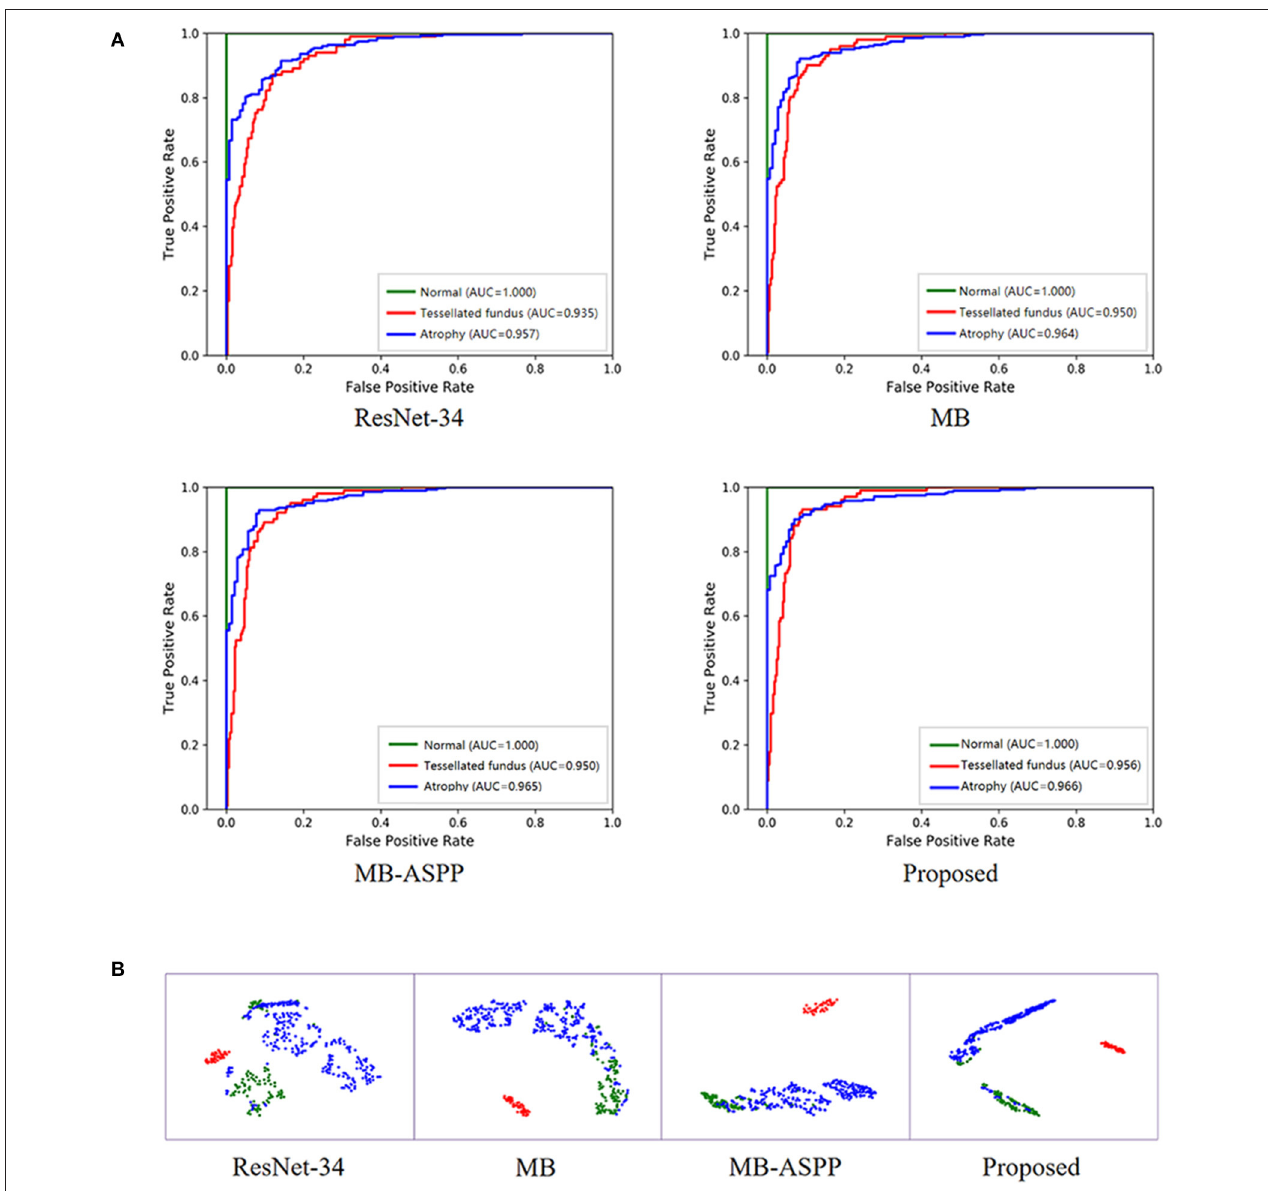
FIGURE 6 | Performance of AI system in category A with three sub-grades. (A) The ROC curves of different methods for category A with three sub-grades. AUC, area under the curve; ROC, receiver operating characteristic. (B) The t-SNE visualization of different methods for category A with three sub-grades. Red, blue, and green points represent the normal fundus (no myopic retinal lesions), tessellated fundus, and retinal atrophy,